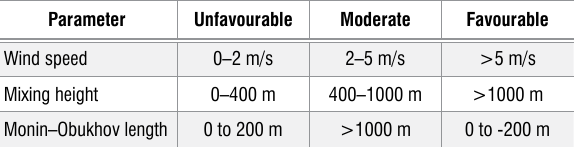
Figure 2: Annual concentrations (µg/cm 3 ) of PM